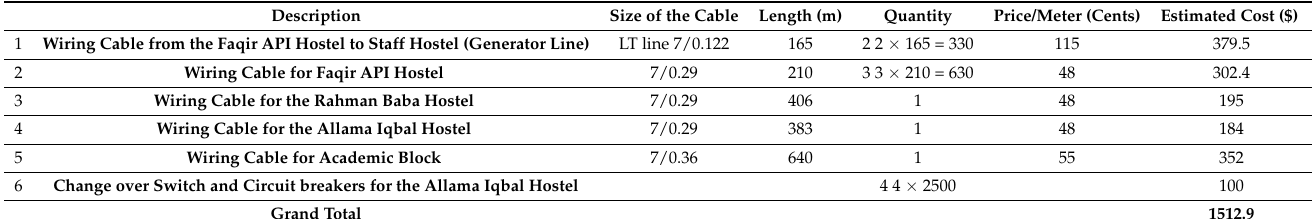
Table 17. Estimated cost of wires and extra equipment used in the proposed balanced load